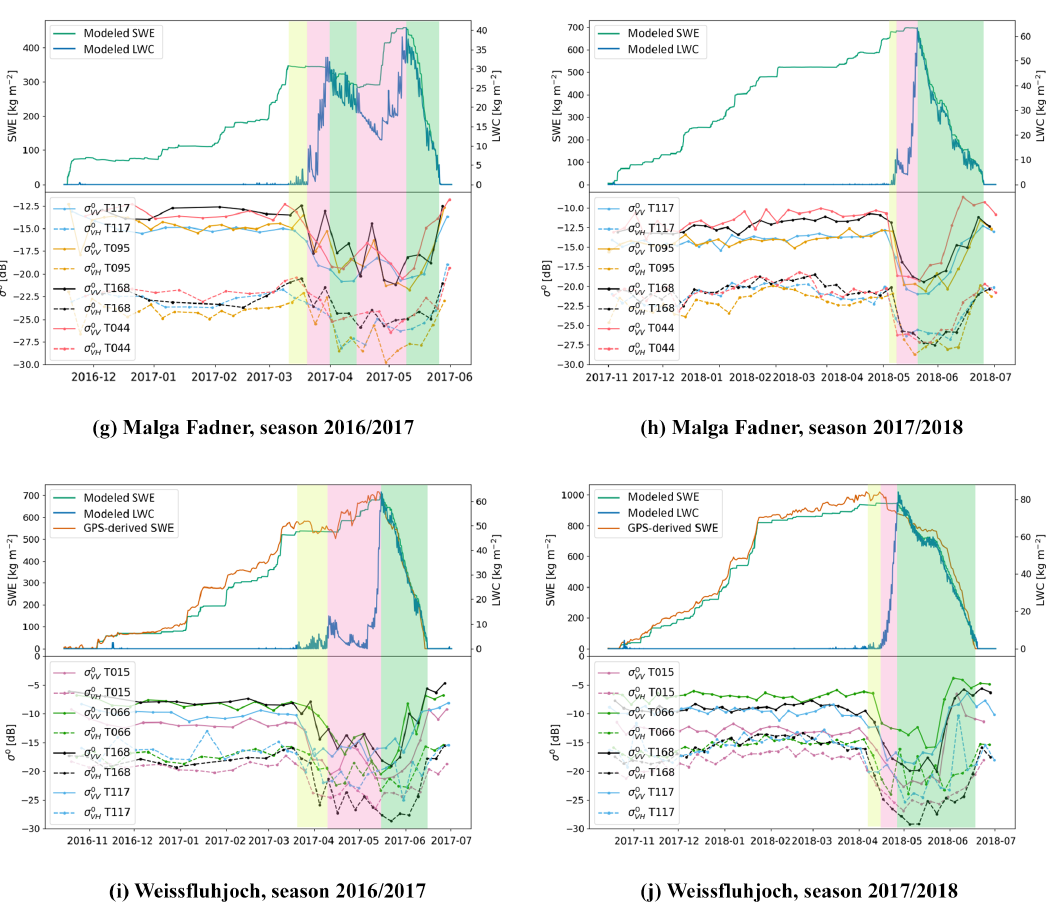
Figure 4. Temporal evolution of the coefficient of backscattering acquired over the five test sites compared to LWC and SWE measured in situ at the stations (when available) and modeled with SNOWPACK (contains modified Copernicus Sentinel data, 2016/2018, processed by Eurac Research). The three phases during the melting have been identified from the in situ/modeled data. The first phase of moistening is reported in light yellow, the ripening phase in light red and the runoff in light green. For all the test sites we found that the multitemporal SAR measurements confirm the identification of the three melting phases. In particular, we systematically found that the SAR backscattering decreases as soon the snow starts containing water and increases as soon as SWE starts decreasing, which corresponds to the release of meltwater from the